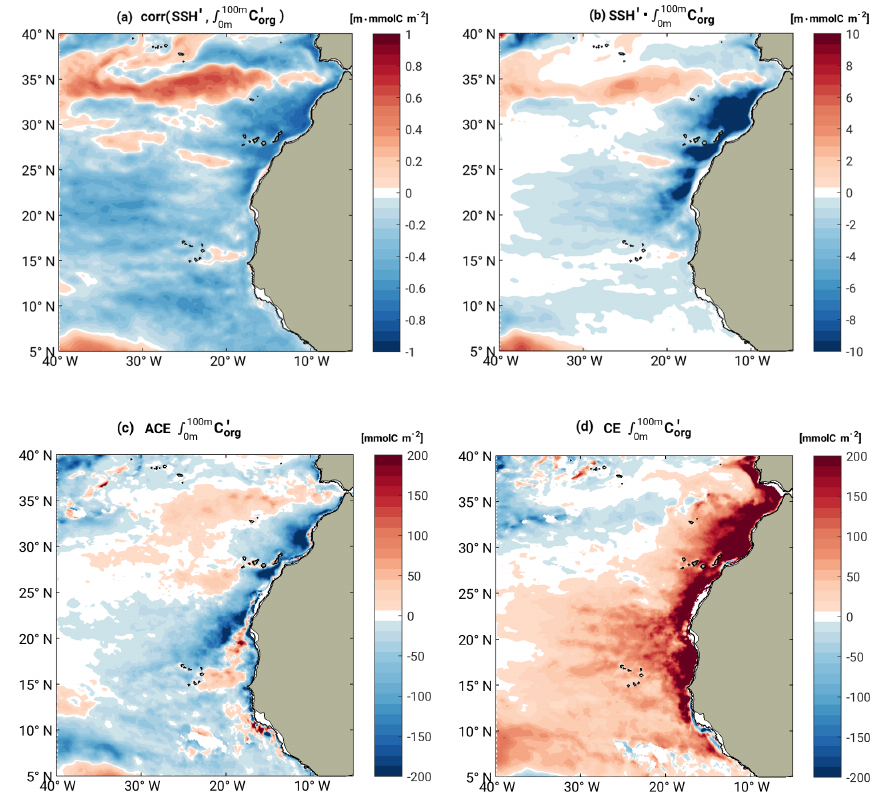
Figure 9. (a) Correlation and (b) covariance of the turbulent SSH anomalies (SSH (cid:48) ) with the top 100m organic carbon stock anomalies, C (cid:48) org stock contained in (c) ACE and (b) CE, C (cid:48) org . Mean R 100m i.e., R 100m 0 0